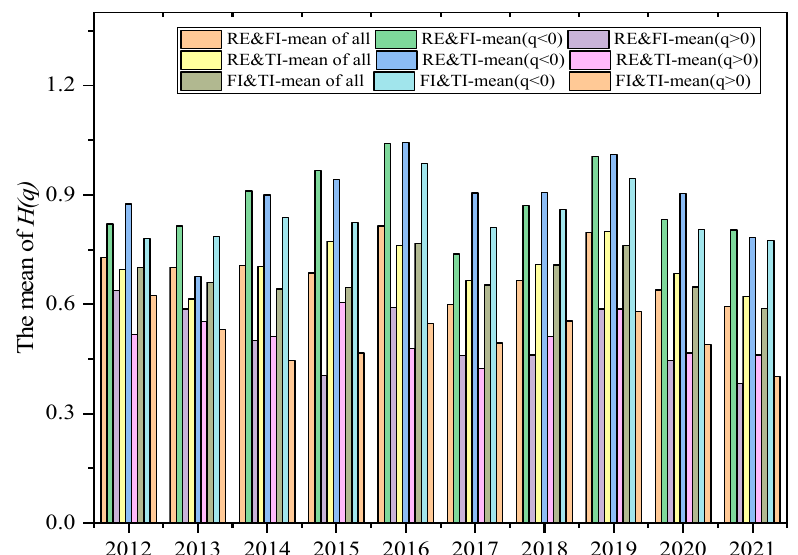
Figure 5. Tim-evarying memory analysis of H ( q ) mean among TI, FI, and RE.